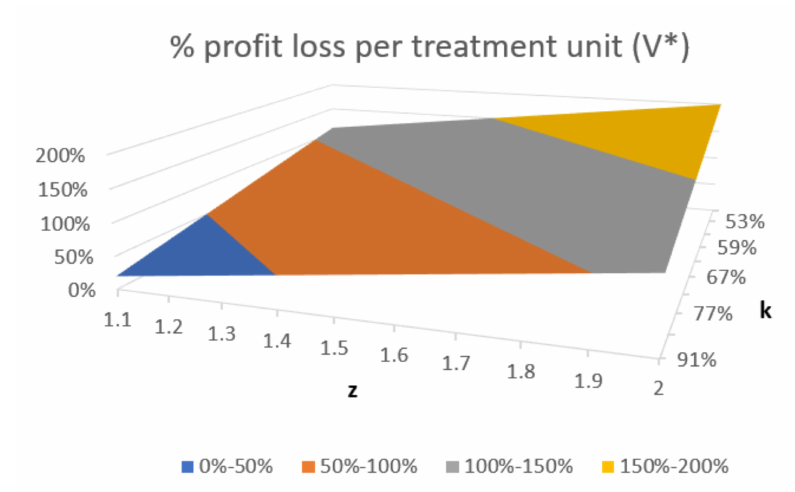
Figure 3. Percentage markup loss per treatment unit ( V *) of an increase in costs ( z ) and a reduction in treatment volumes ( k ), keeping dental charges unchanged ( p = 200 monetary units; c = 100 monetary